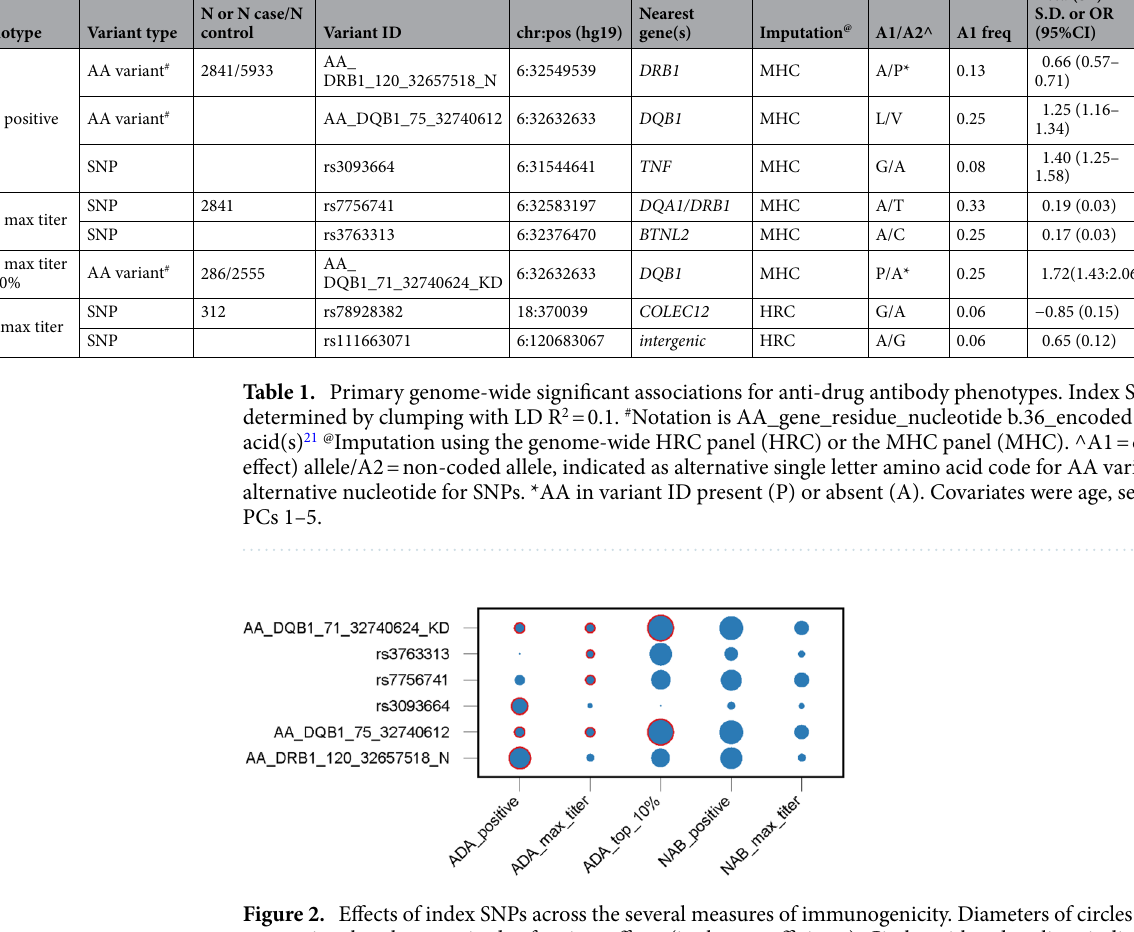
Figure 2. Effects of index SNPs across the several measures of immunogenicity. Diameters of circles are proportional to the magnitude of variant effects (i.e. beta coefficients). Circles with red outlines indicate associations reaching genome-wide significance. See also Table S5.